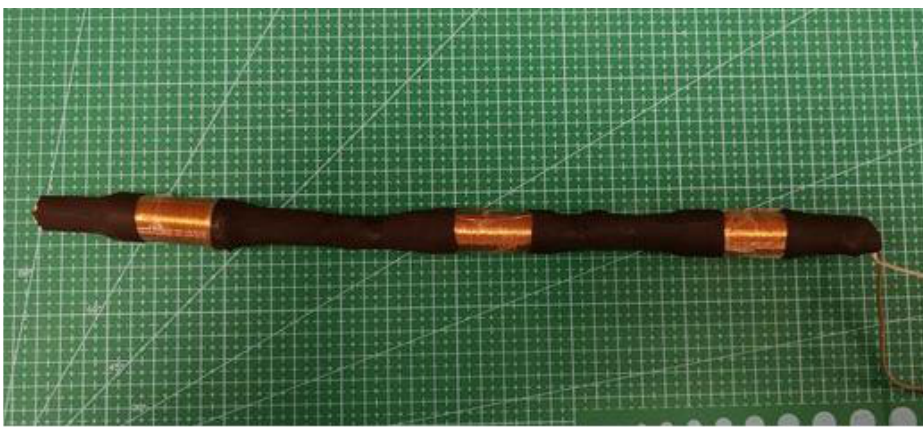
Figure 6. Microgenerator system of three generators. Figure 7 shows the output of the microgenerator system when an external vibration is applied. The external vibration had a frequency of 10 Hz, which is a common vibration frequency found in ships [15]. This output was achieved during the experiment described later in this paper by attaching the energy harvester to a laboratory oscillation generator (see Figure 8), excited by a sinusoidal signal, resulting in an acceleration of 10 m/s 2 peak-